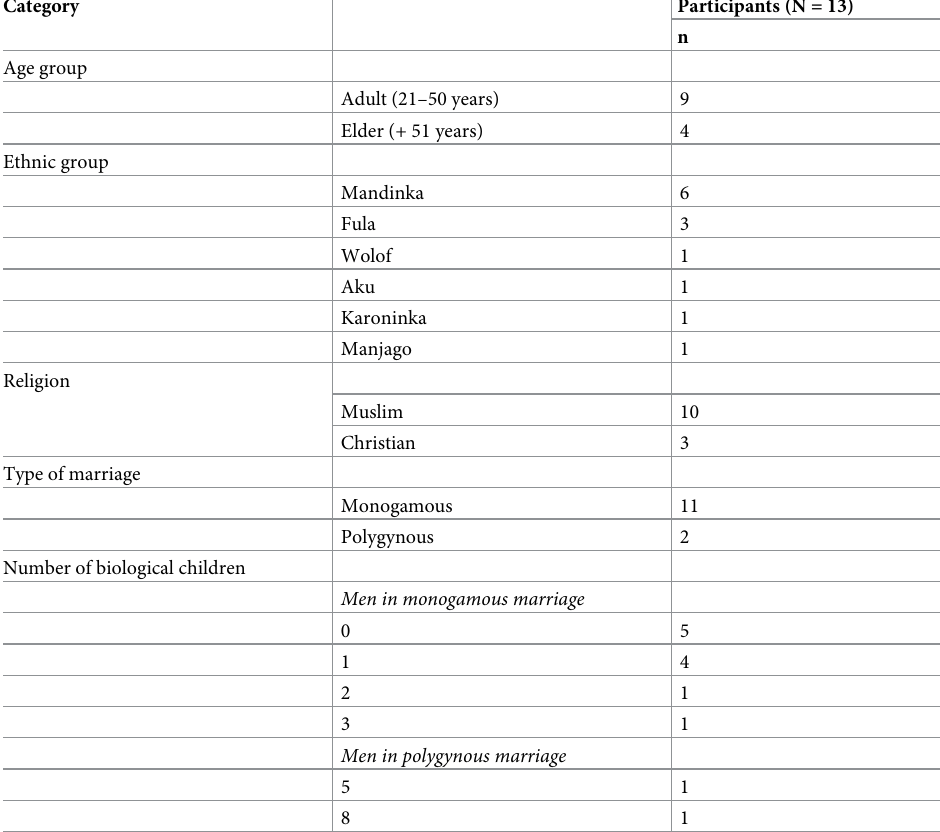
Table 1. Study participants’ key characteristics, including age category, ethnic group, religion, type of marriage and number of biological